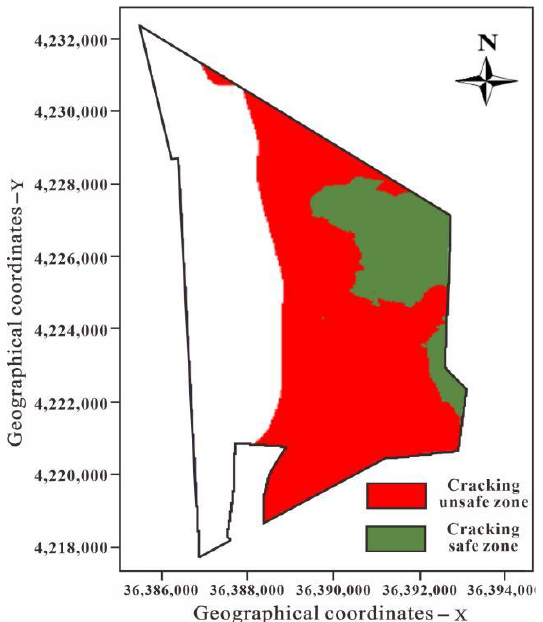
Figure 5. Partition diagram of cracking safety prediction.